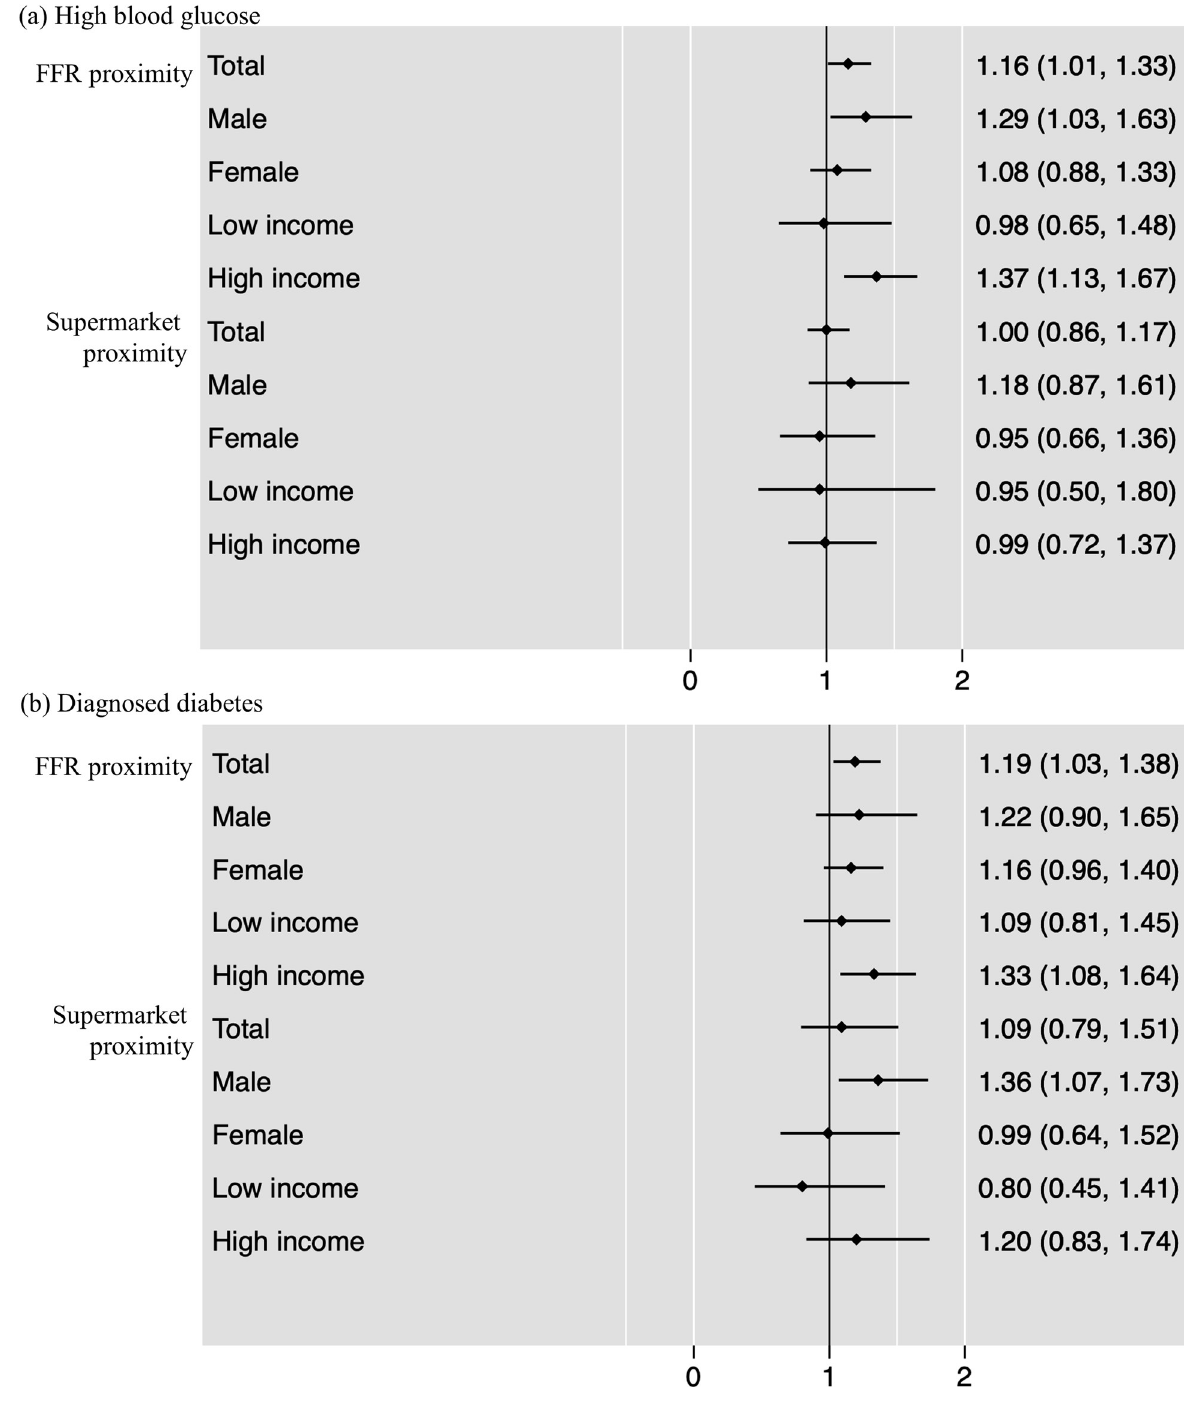
Fig 3. ORs for the associations between diabetes mellitus and proximity of food outlets. Note: The values show AORs from logistic regressions in panels B and C; 95% CIs in brackets; horizontal bars = 95% CIs. Density = the number of each food outlet per total number of food outlets within 300 m of a resident’s home address. Proximity = 1 if having at least 1 outlet within 100 m of a resident’s home address and 0 if otherwise. AOR, adjusted odds ratio; FFR, fast-food restaurant; OR, odds ratio.